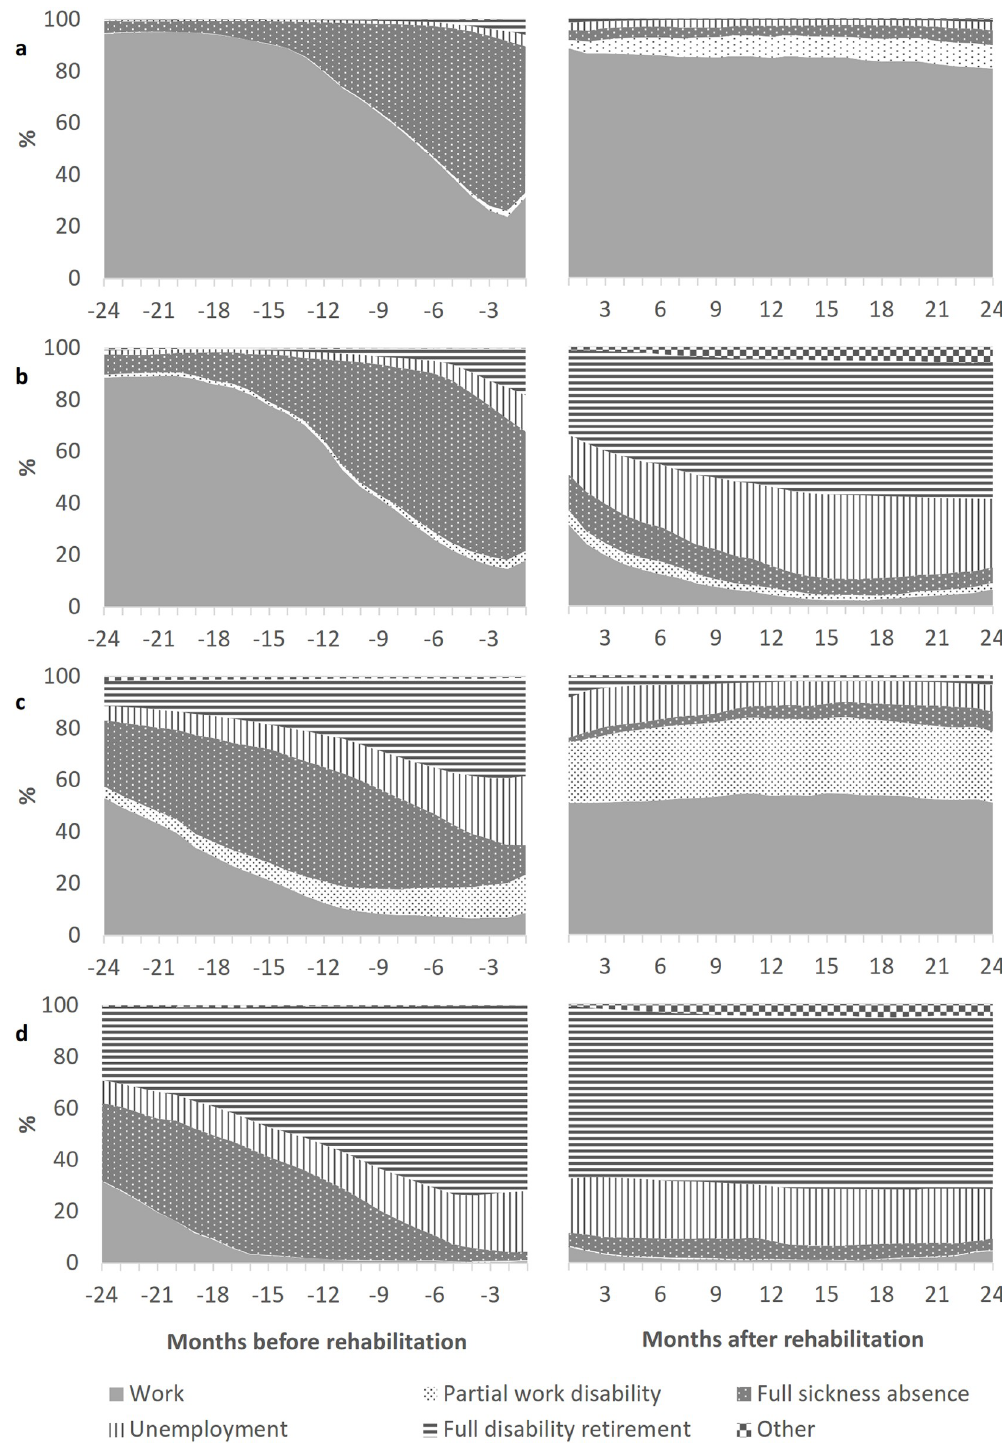
Fig 2. Changes in labour market status over the period of two years before and two years after vocational rehabilitation among the trajectory groups of work participation: a) High–Resumed (N = 2554), b) High–to–Negligible (N = 1483), c) Medium–Resumed (N = 1828), and d) Longstanding Negligible (N = 1315).